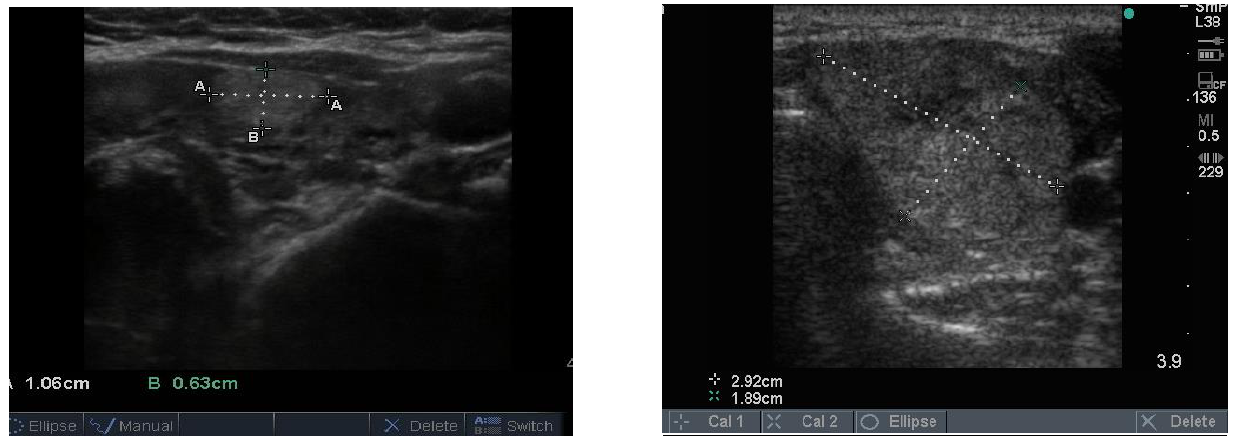
Figure 4. Two examples of follicular nodules that were shown at surgery to be benign. The nodules are roughly oval shaped, slightly hyper echoic and have sharp edges and, particularly, the bigger of the two, thick halos.